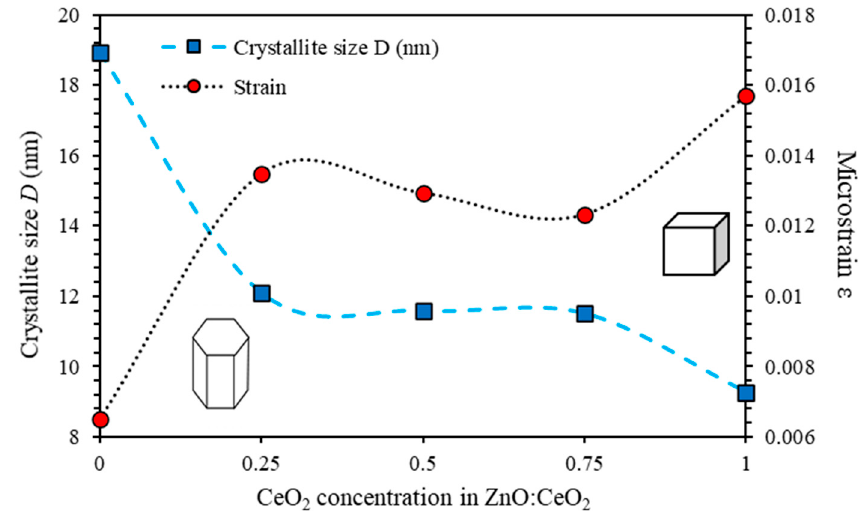
Figure 2. The crystallite size, D and the microstrain ε of ZnO:CeO 2 mixed oxides thin films as a function of CeO 2 concentration calculated using Debye Scherrer’s equations.